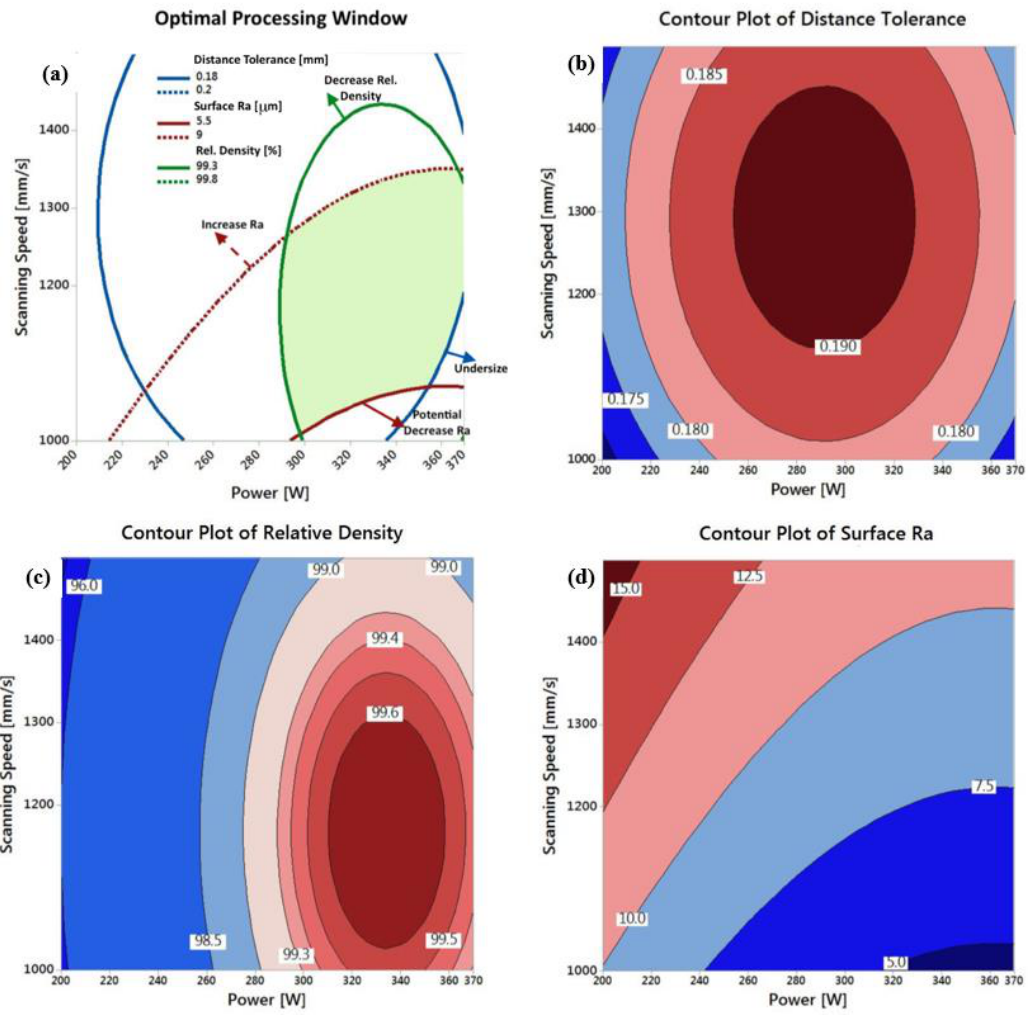
Figure 18. ( a ) Optimal processing window generated for the AlSi10Mg alloy at the hatch spacing value of 0.19 mm and the effect of laser power (W) and scan speed (mm/s) on ( b ) distance tolerance (mm), ( c ) relative density (%), and ( d ) surface roughness Ra ( µ